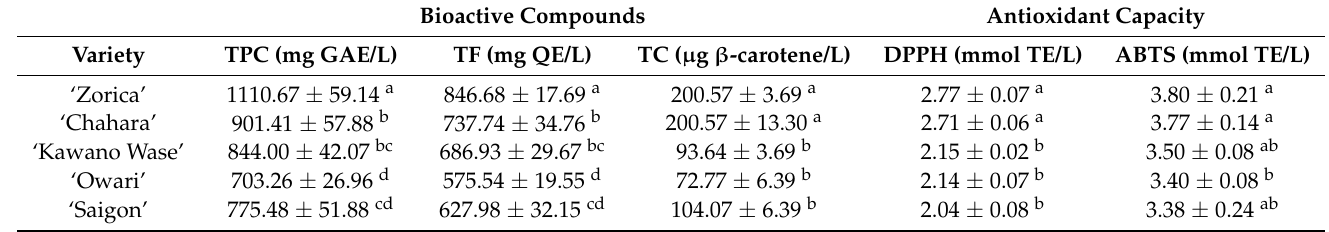
Table 3. Bioactive compounds in mandarin juice as total polyphenolic compounds (TPC), total flavonoids (TF), total carotenoids (TC) and antioxidant capacity, as determined with two methods (DPPH and ABTS) in different varieties of mandarins from Neretva valley (Croatia). Results are expressed per L of mandarin